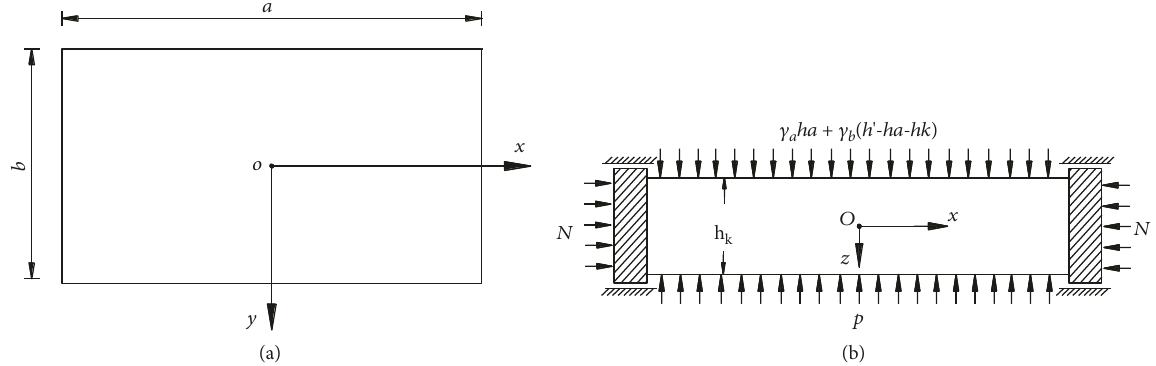
Figure 2: (a) Plan of plate model and (b) pro fi le map of plate